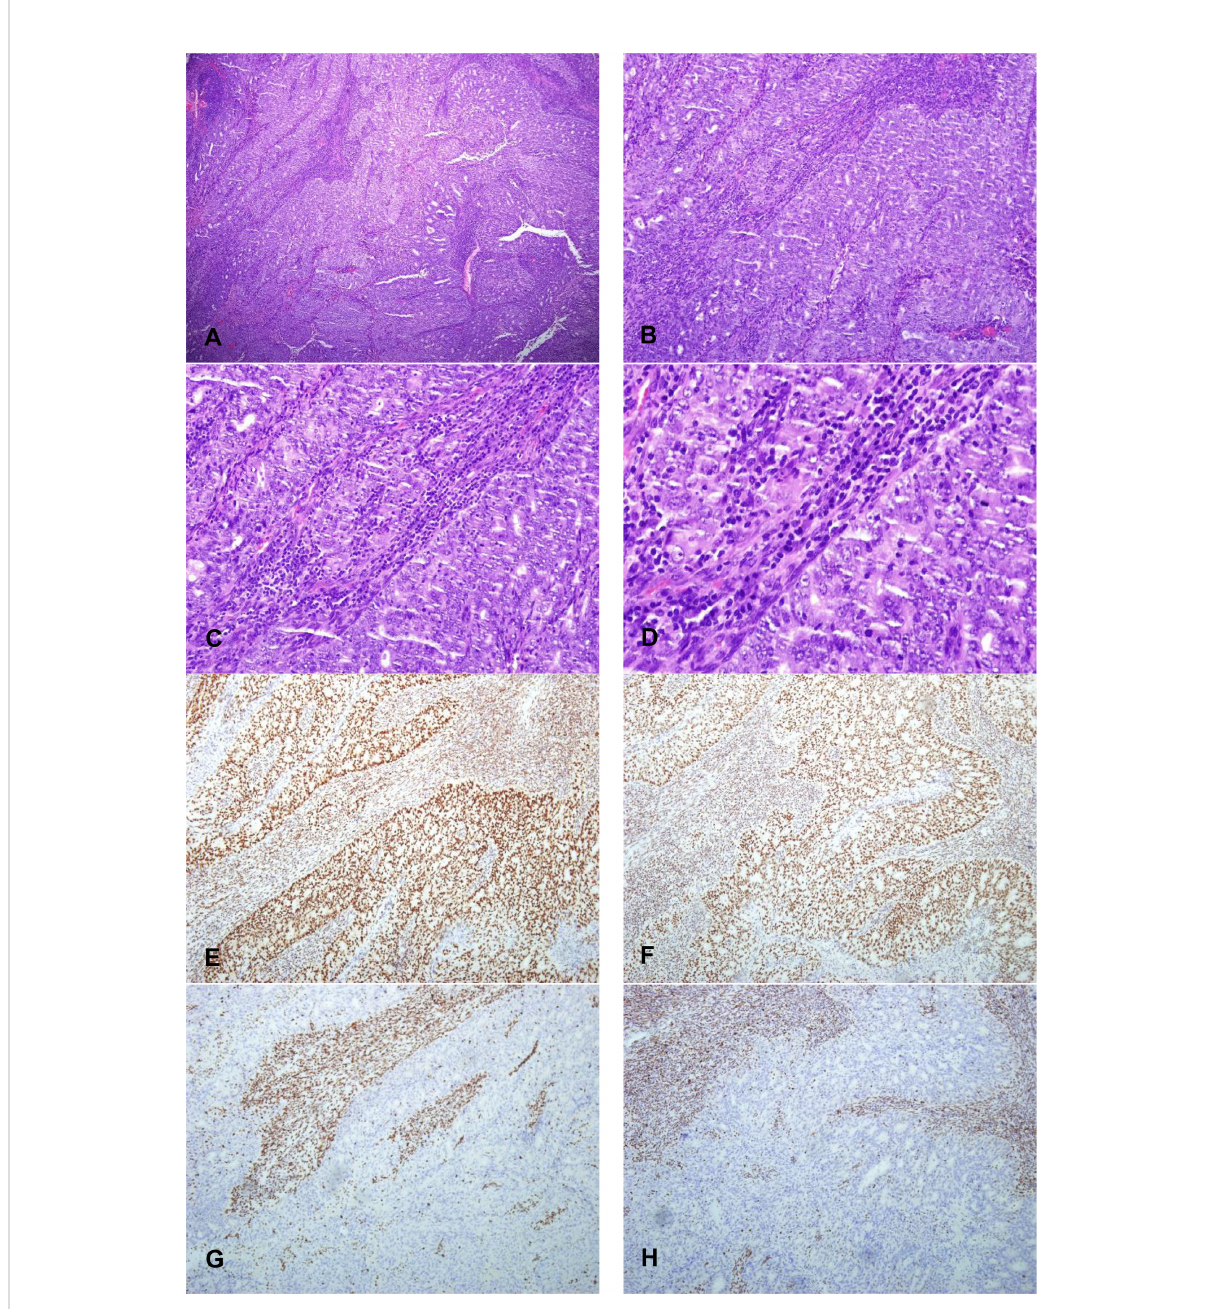
FIGURE 5 The morphology of high-grade endometrioid adenocarcinoma of MSI-H subtypes and its expression pattern of MMR protein (X100). (A) X40 and (B) X100: The morphological characteristics of MSI-H subtype are similar to high-grade serous carcinoma. Sheet necrosis is easy to see; the stroma is rich in in fl ammatory cells dominated by lymphocytes (C) X200 and (D) X400: The nucleus is signi fi cantly atypia, and the mitotic image is easy to see of EECs of MSI-H subtypes. (E, F) MLH1 and PMS2 proteins expression pattern are positive expression pattern (X100). (G, H) MSH2 and MSH6 proteins expression pattern are completely absent